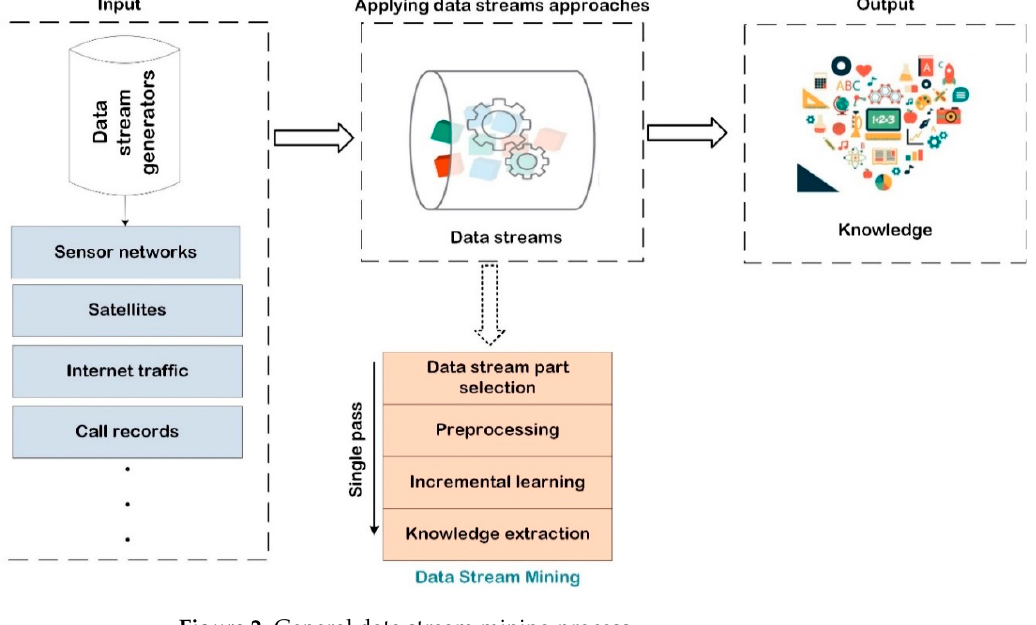
Figure 2. General data stream mining process. Table 1. Differences between stream data mining and traditional data mining.